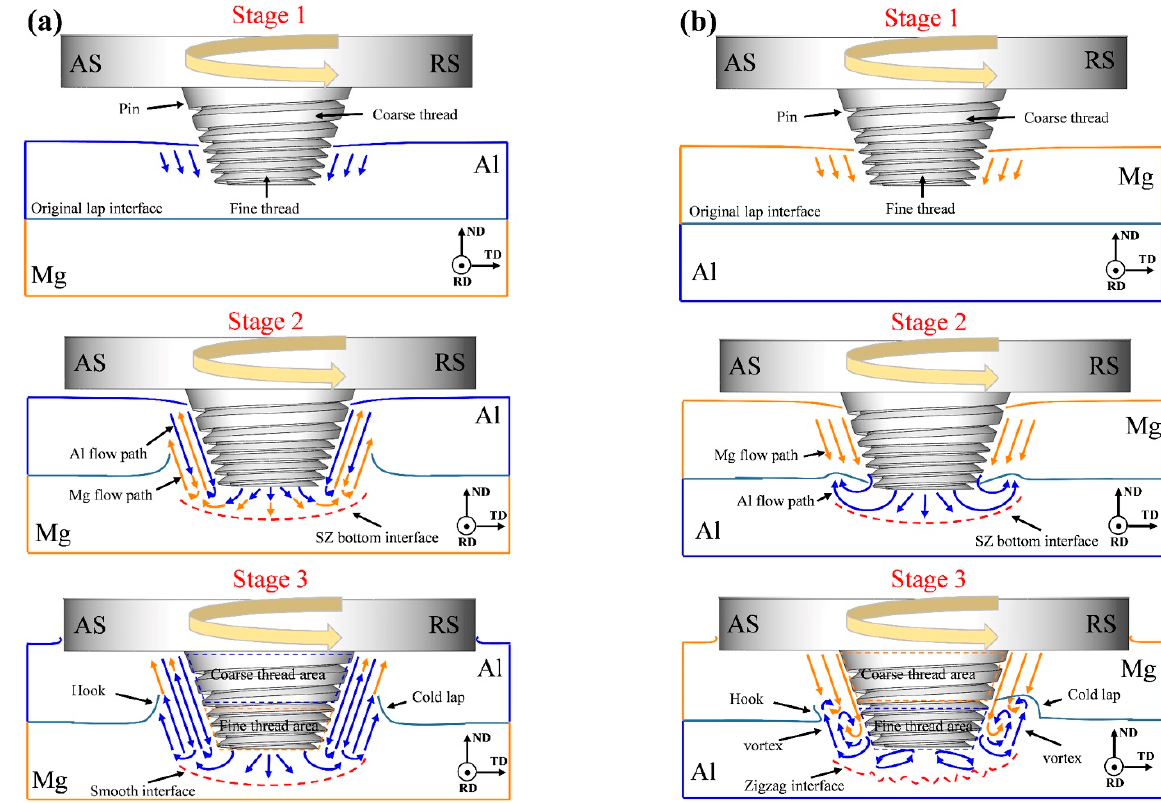
Figure 15. Schematic of material flows in different lap configurations: ( a ) Configuration Al-Mg; ( b ) Configuration Mg-Al.